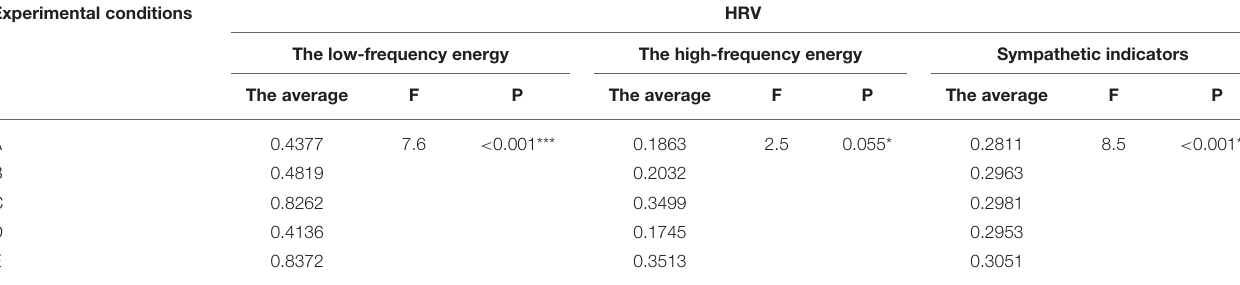
TABLE 3 | Test results. Experimental conditions